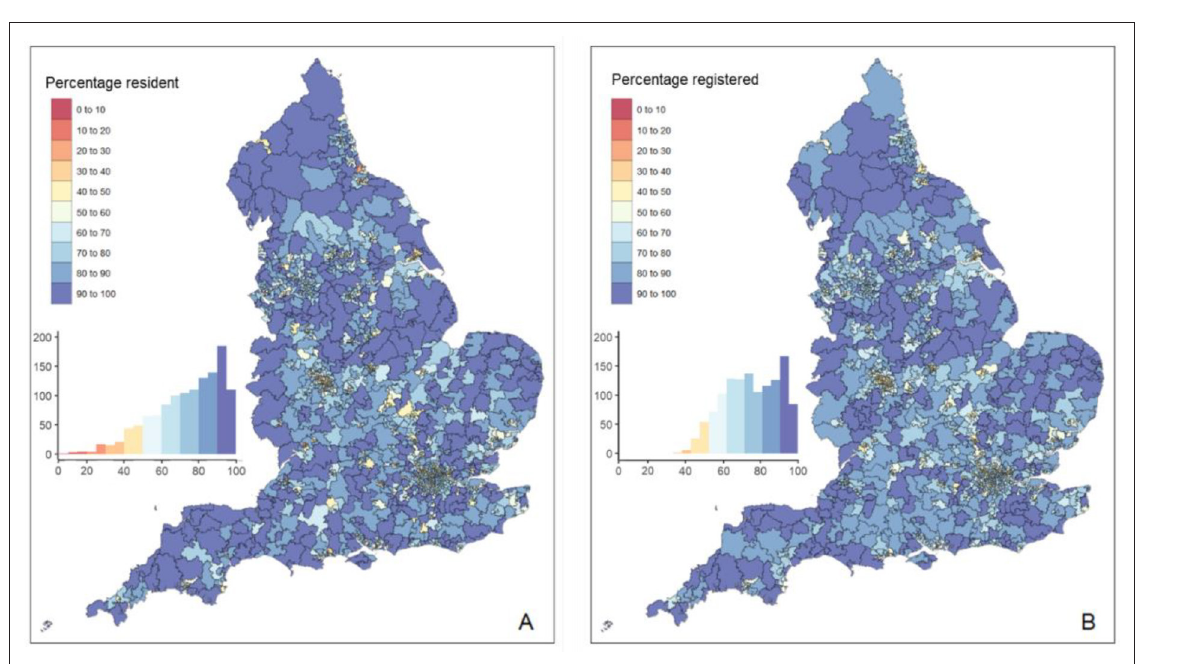
Figure 2 Primary care network (PCN) populations: panel A shows the percentage of the PCN registered population who are resident in the catchment of the PCN; panel B shows the percentage of each PCN catchment population who are registered to a GP practice within the PCN Footnote: the unit of geography displayed is the PCN catchment